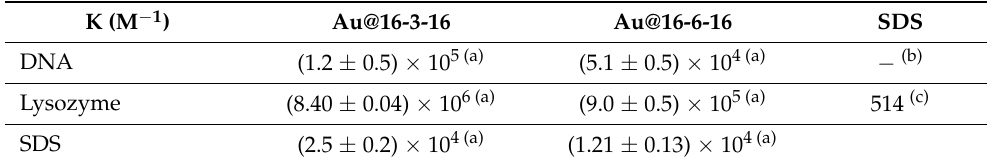
Table 3. Equilibrium binding constants for the interaction among the reactants. K (M − 1 ) Au@16-3-16 Au@16-6-16 SDS DNA